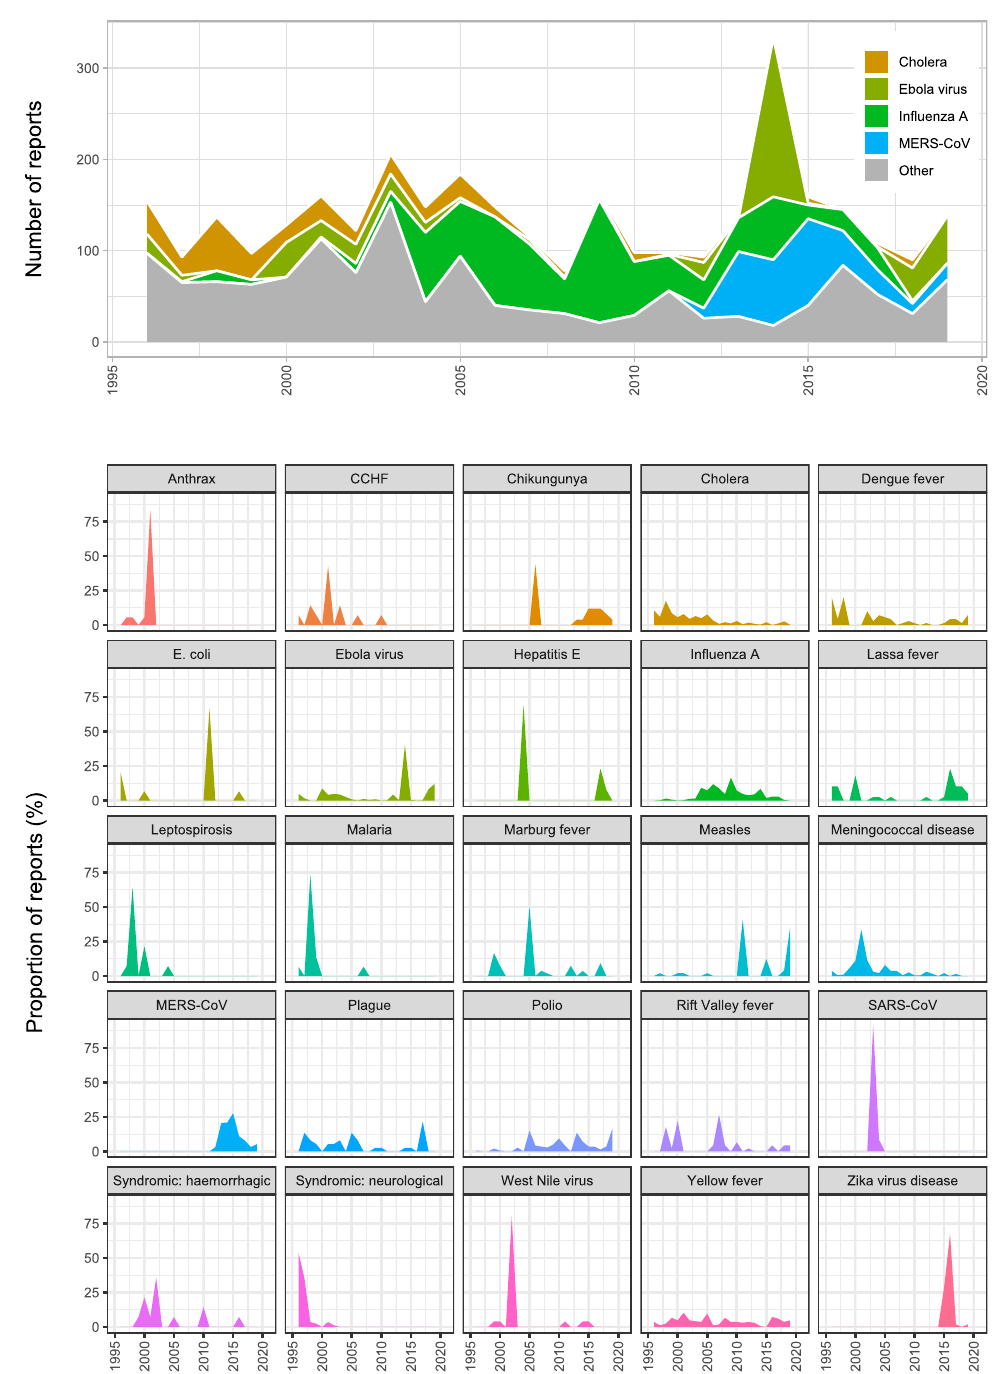
Fig 1. The distribution of outbreaks through time. (top) Number of reports per year, broken down to highlight the top four diseases, which are reported substantially more often than all others (see Table 1). (bottom) The proportion of total reports of a disease, across years, that occur in a given year, for the top 25 reported diseases in alphabetical order.